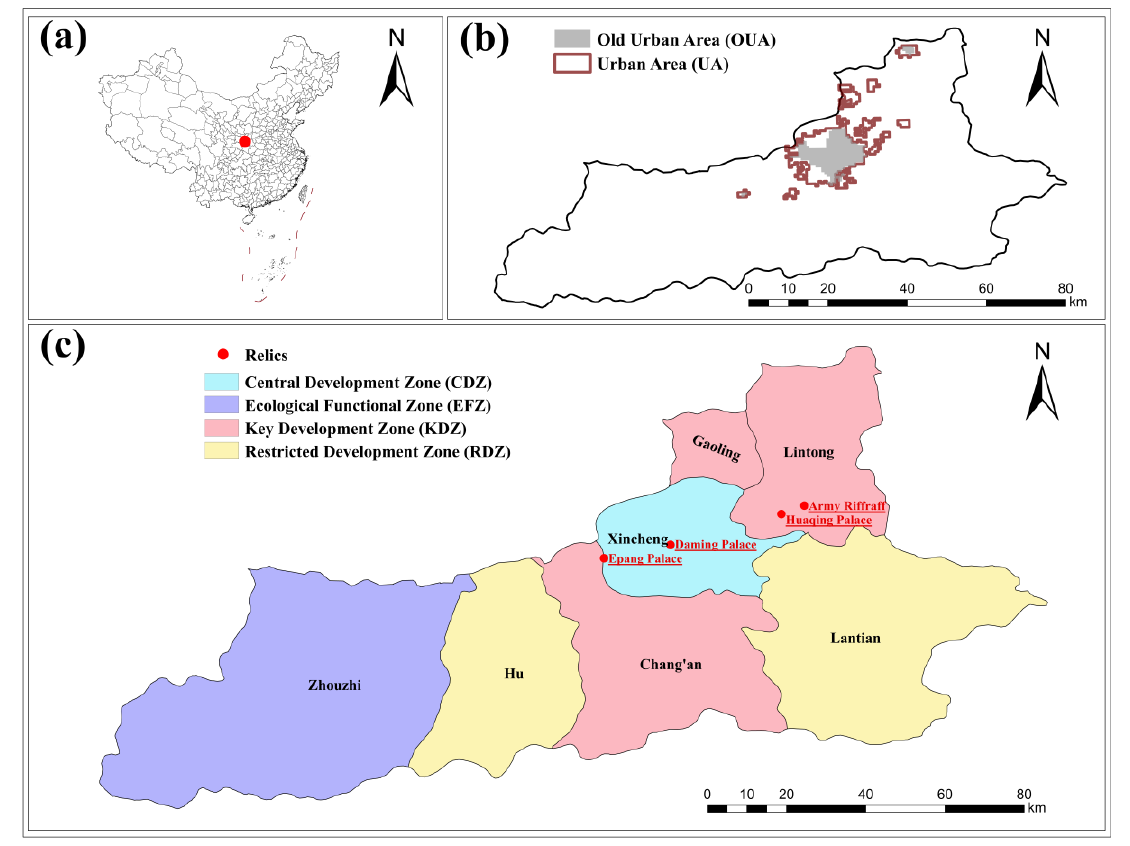
Figure 1. Location of Xi’an city, China ( a ). Locations of the urban area and old urban area ( b ). Locations of Xi’an’s four functional zones and four relics ( c ).